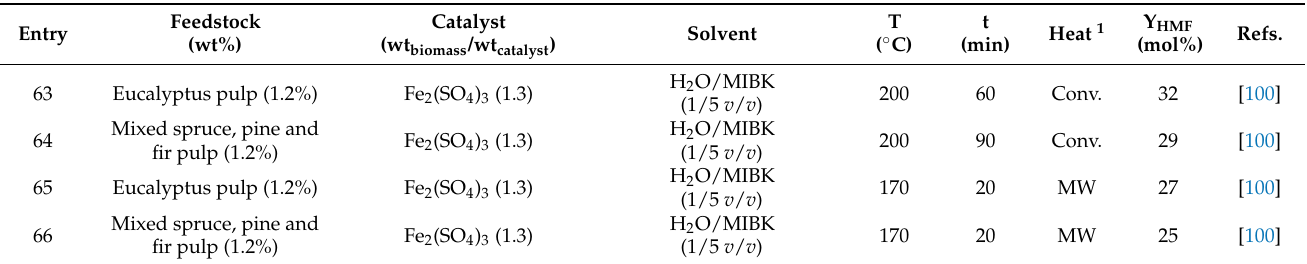
Table 4. HMF production starting from raw biomasses in biphasic and/or multiple-solvent systems with inorganic salts and combinations of them with